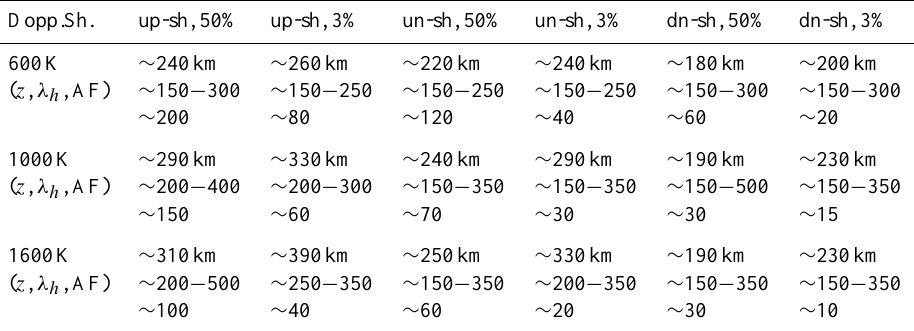
Table 2. Approximate maximum penetration altitude, the range of GW horizontal wavelengths that reach these altitudes, and the amplifi- /u 0 cation factor for GW horizontal velocities at this altitude (AF= u 0 ) for thermospheric temperatures of 600, 1000, and 1600K (top to h h 80 bottom), up-shifted, unshifted, and down-shifted GWs (left to right) assuming a zonal wind in the thermosphere of 100ms − 1 , and surviving momentum flux fractions of 50% and 3%. Dopp.Sh. up-sh,